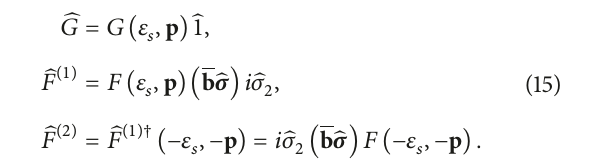
Figure 2: Dyson’s equations for the anomalous vertices (a) and the gap equations (b). Shaded rectangles represent the pairing